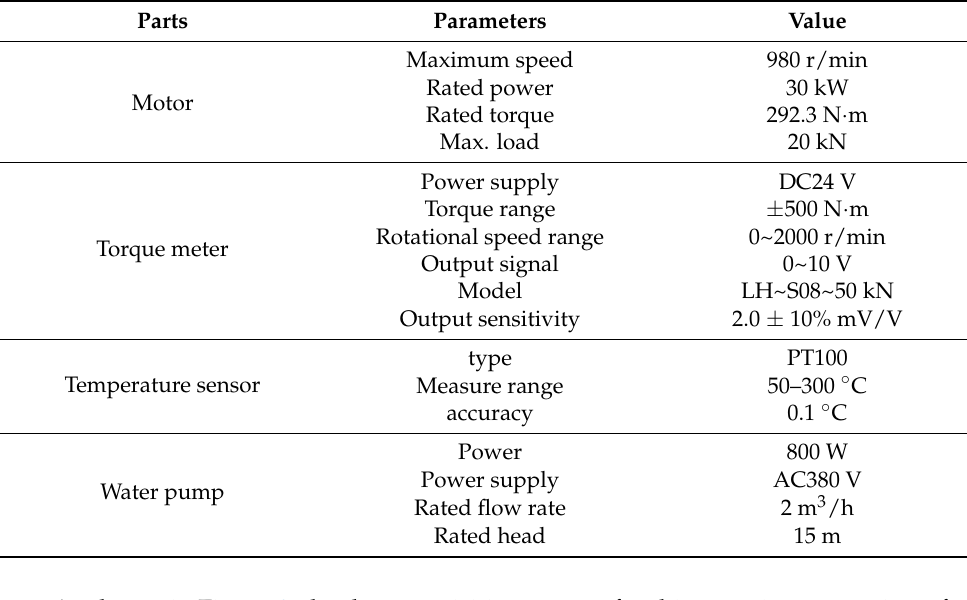
Table 2. Basic parameters of each item of equipment.